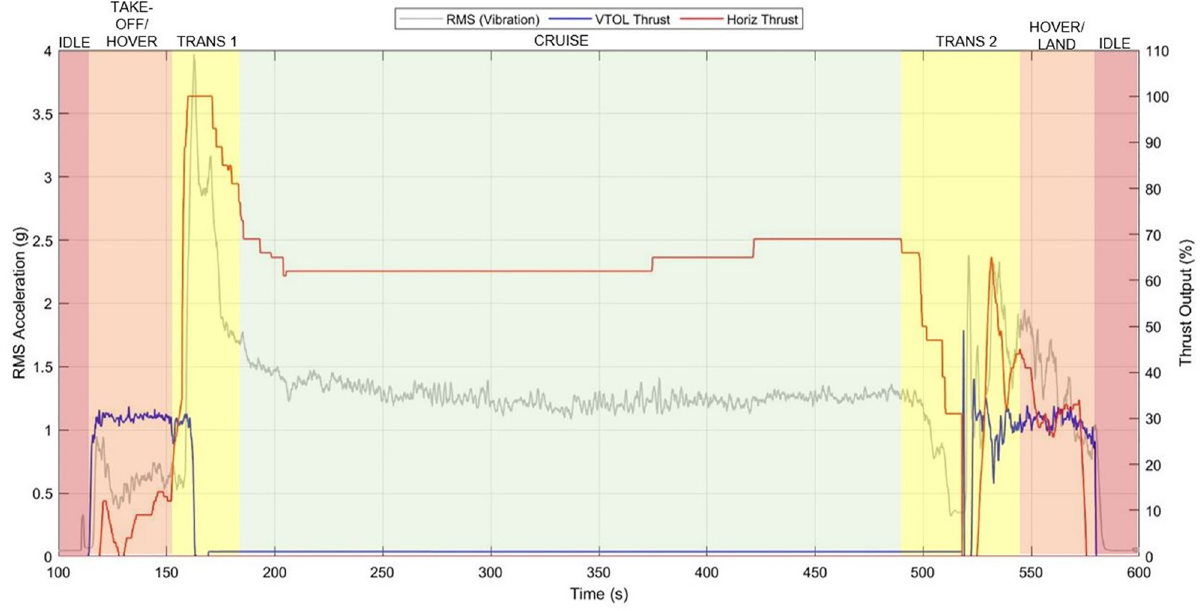
Fig 7. Throttle outputs compared to magnitude of vibration during each stage of flight with the Skylift V50 (Mugin 5 Pro) VTOL drone. High thrust periods correspond with the greatest peaks in vibration measured. Trans 1 = Transition from hover to cruise. Trans 2 = Transition from cruise to hover. The RMS acceleration is calculated with as a 1 second sliding window and the mean is subtracted from the data.